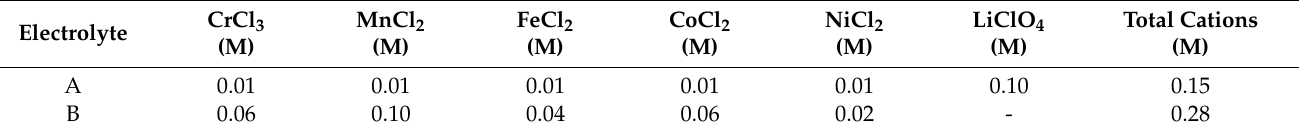
Table 1. Solutions for electrodeposition: metal chlorides with various concentrations in an organic solvent of DMF and CH 3 CN (4:1 by